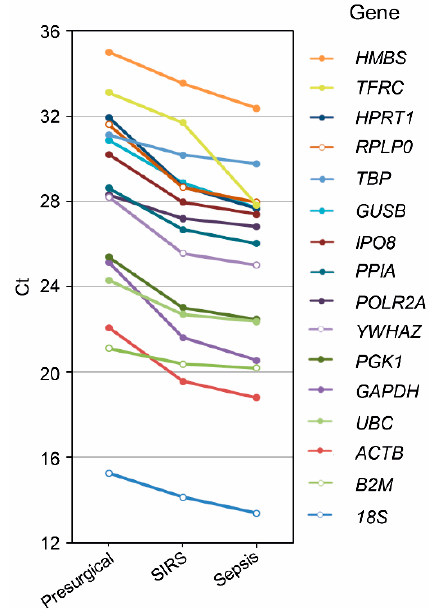
Figure 3. RT-PCR screen for endogenous reference genes in presurgical, SIRS, and sepsis discovery set granulocytes. Sixteen known reference genes assembled in the TaqMan Array Human Endogenous Control Panel were tested in randomly selected discovery set samples (presurgical, n = 5; SIRS, n = 5; sepsis, n = 6). Threshold cycle (Ct) values are represented as group averages. Data points are connected by lines to aid visual comparisons between groups. The overall mean coefficient of variation (CV) for these determinations was 4.3%. CV values were < 7.2% except for determinations of 18S in SIRS (22.3%) and sepsis (14.4%).